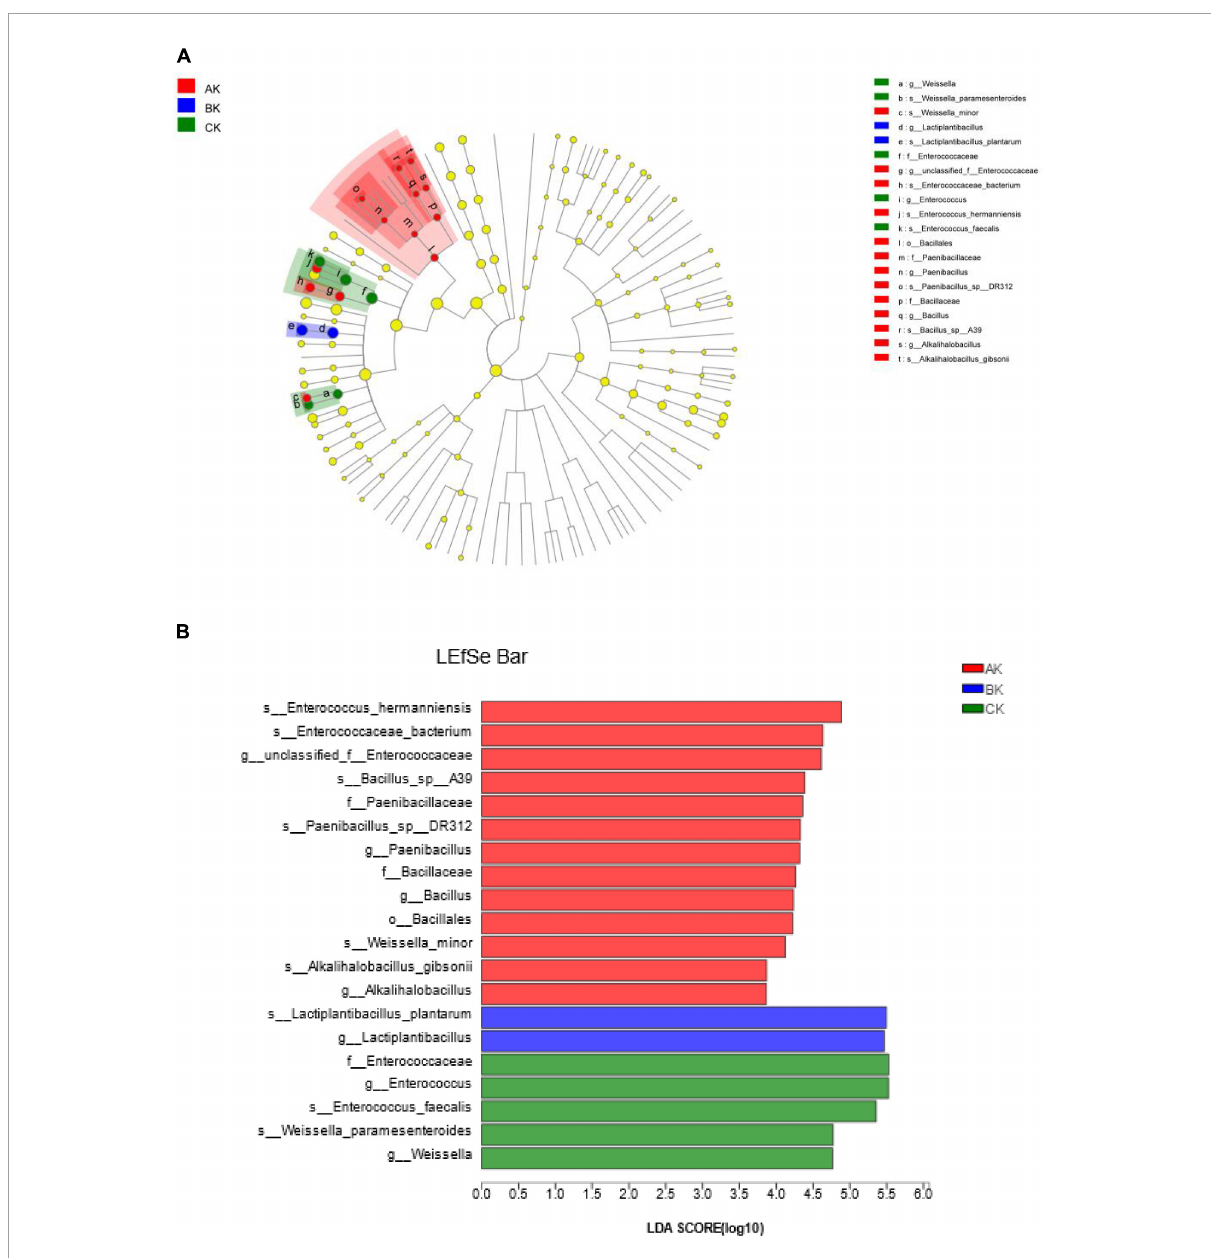
FIGURE4 Cladogram showing the phylogenetic distribution of bacteria after 60 days of silage at different harvests. (A) Indicator bacteria with an LDA score of 2 or more in the silage bacterial community under different treatments. (B) Areas of different colors represent different treatments (red, AK; blue, BK; green, CK). Circles indicate the phylogenetic level from the kingdom to the species level. Each node (small circle) represents a taxonomic unit. Yellow nodes indicate that the two groups of bacteria were not statistically or biologically different. The diameter of each circle is proportional to the abundance of the